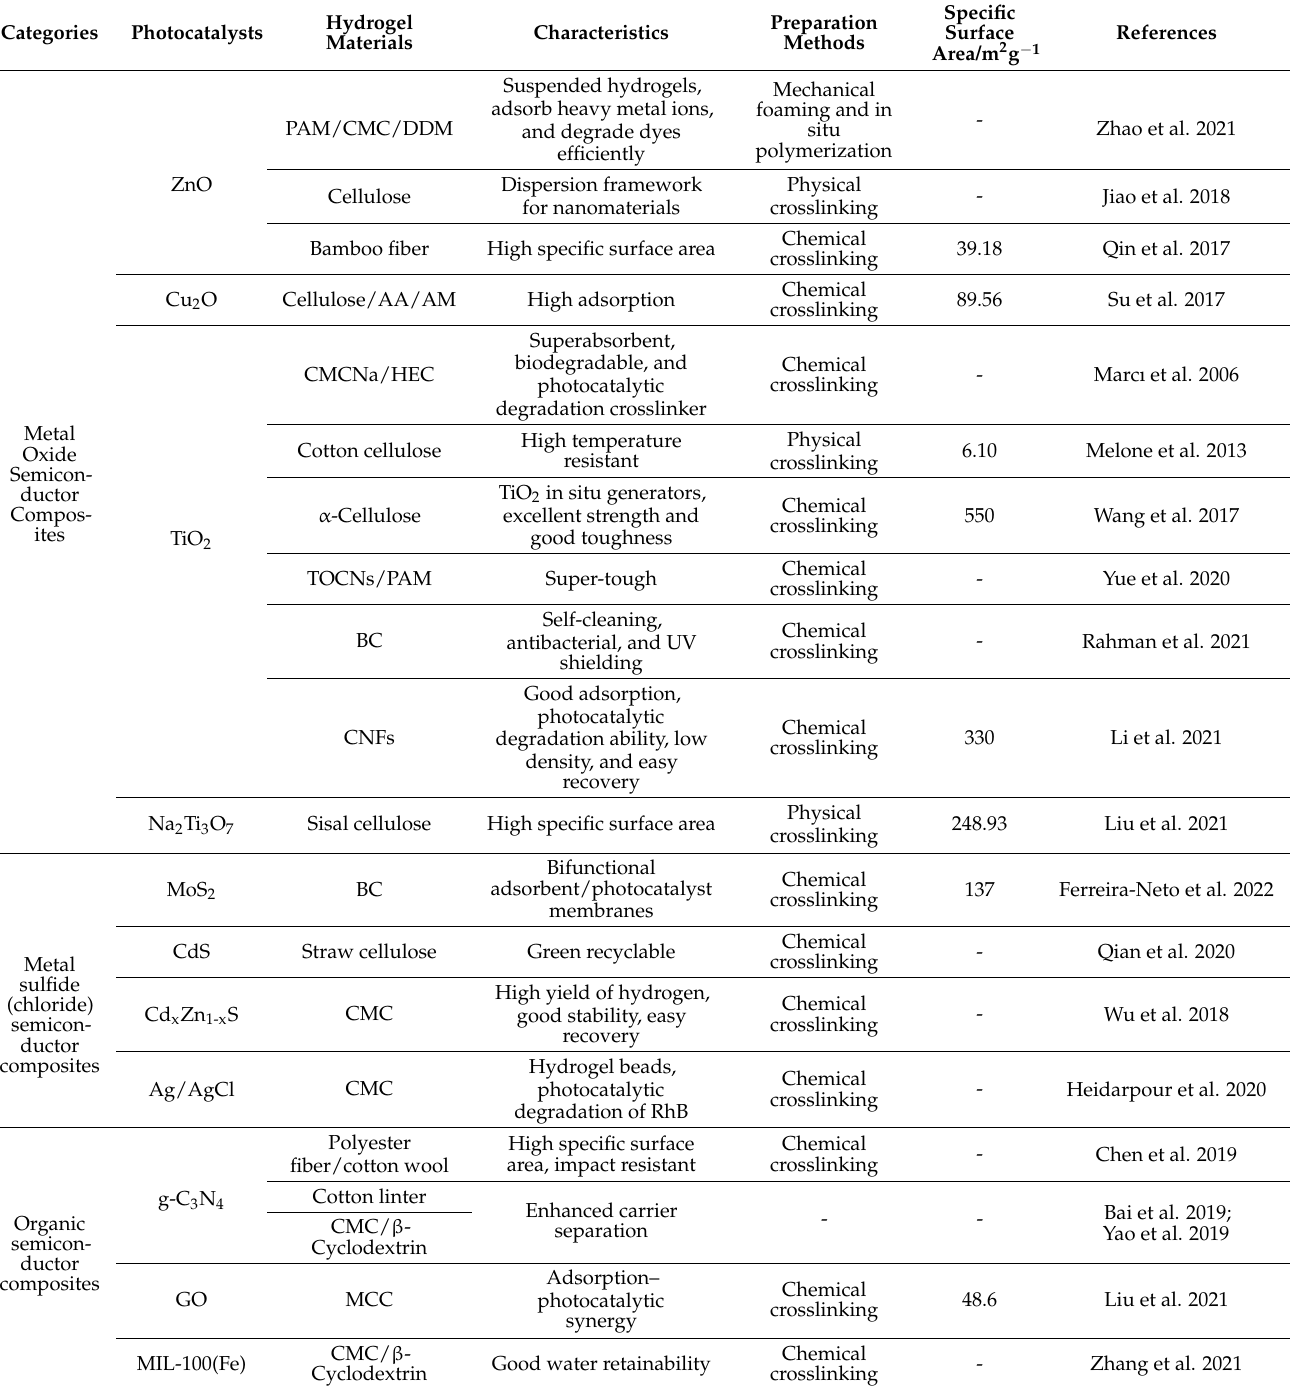
Table 1. Classification of cellulose-based hydrogel photocatalytic